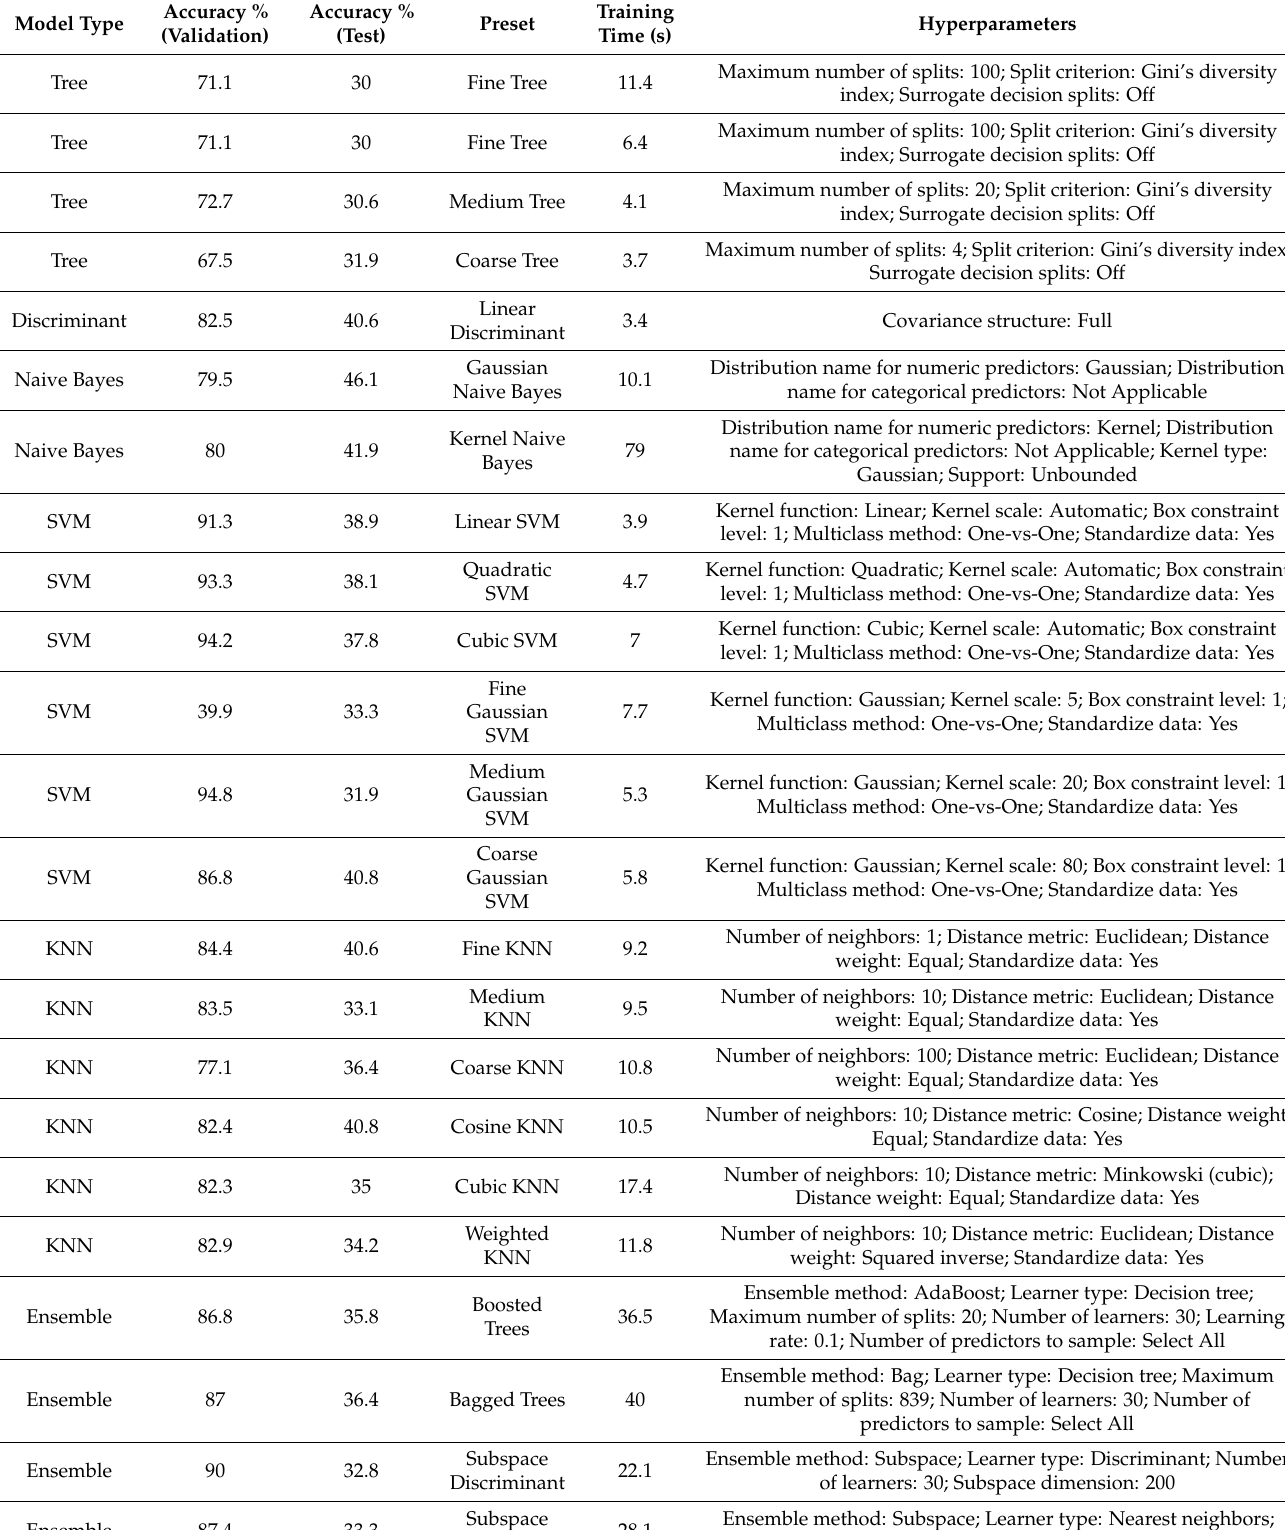
Table A2. Hyperparameters of experimented presets with 520 × 514 px images; training data observa- tions: 840; predictors: 400; response class names: annealing, quenching and quenching + tempering; validation: five-fold cross validation; and test data observations: